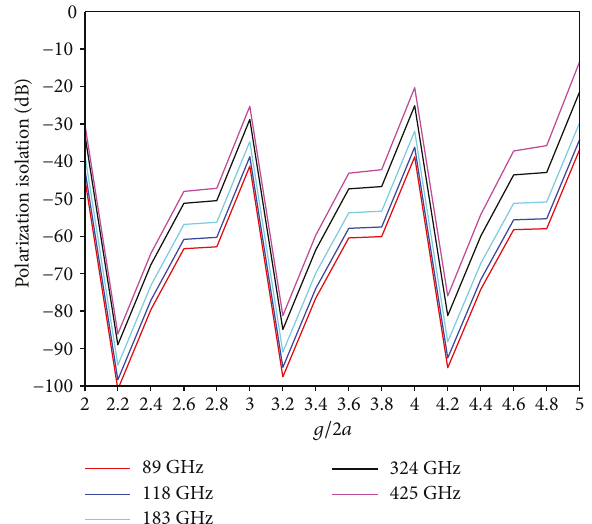
Figure 6: The relationship between pitch-to-width ratio g/ 2 a and polarization isolation (dB) at di ff erent frequencies of 89/118/183/ 324/425